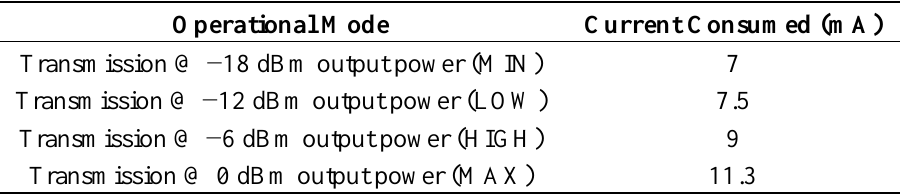
Table 1. Operational modes and current consumptions of